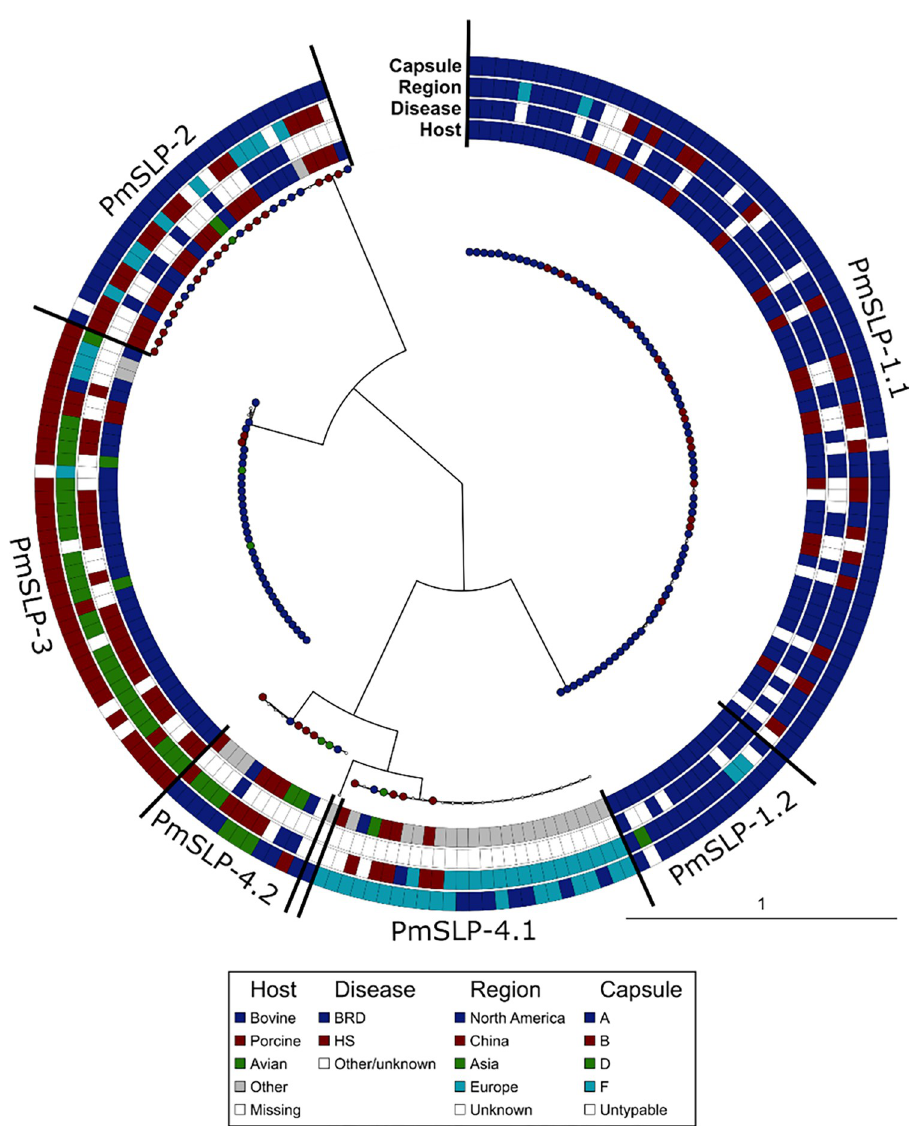
Fig 1. Phylogenetic diversity of PmSLP mature protein sequences from published isolates of P . multocida including the associate capsule type, geographic location, associated disease, and animal host. PmSLP sequences separate into four distinct clusters, two of which are further separated into two sub-clusters